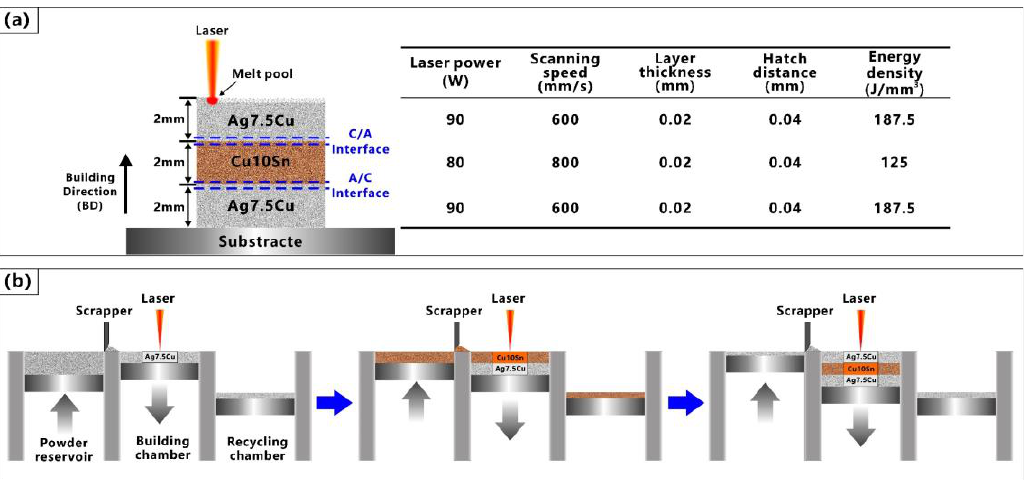
Figure 2. Schematic illustration of LPBF process for fabricating Ag7.5Cu/Cu10Sn/Ag7.5Cu multi- material samples: ( a ) building strategy and parameters; ( b ) printing process.